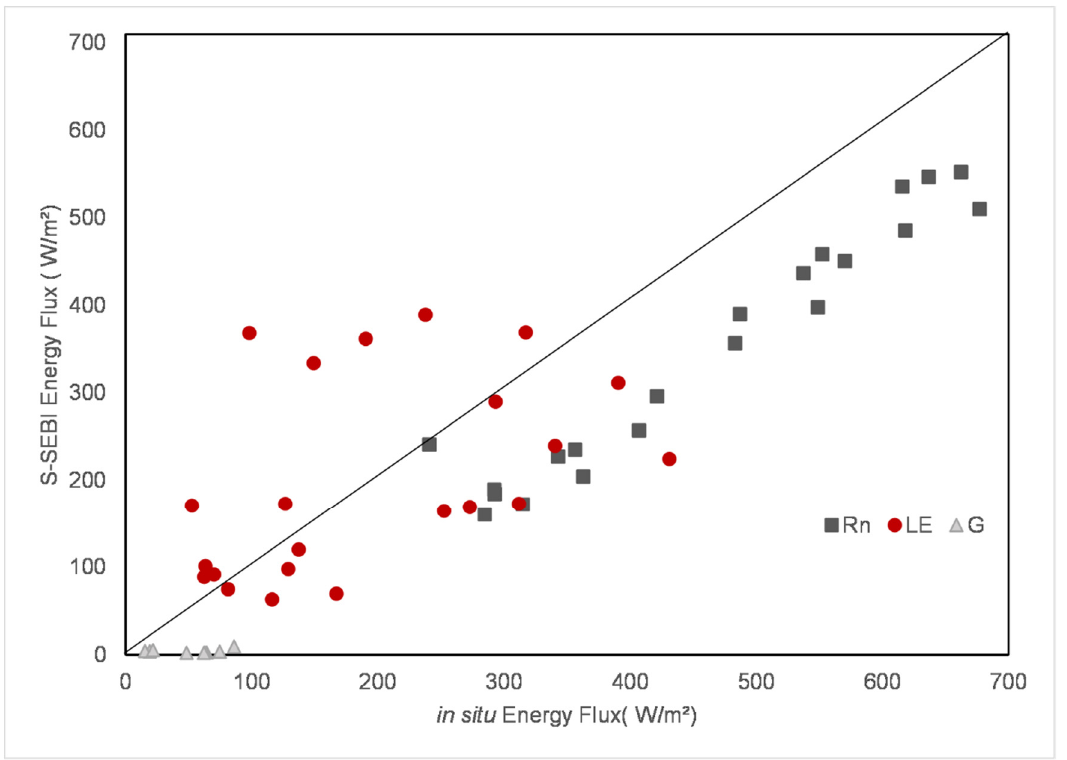
Figure 2. Energy balance components estimated with S-SEBI against in-situ data. The black line represents the 1:1 relation.